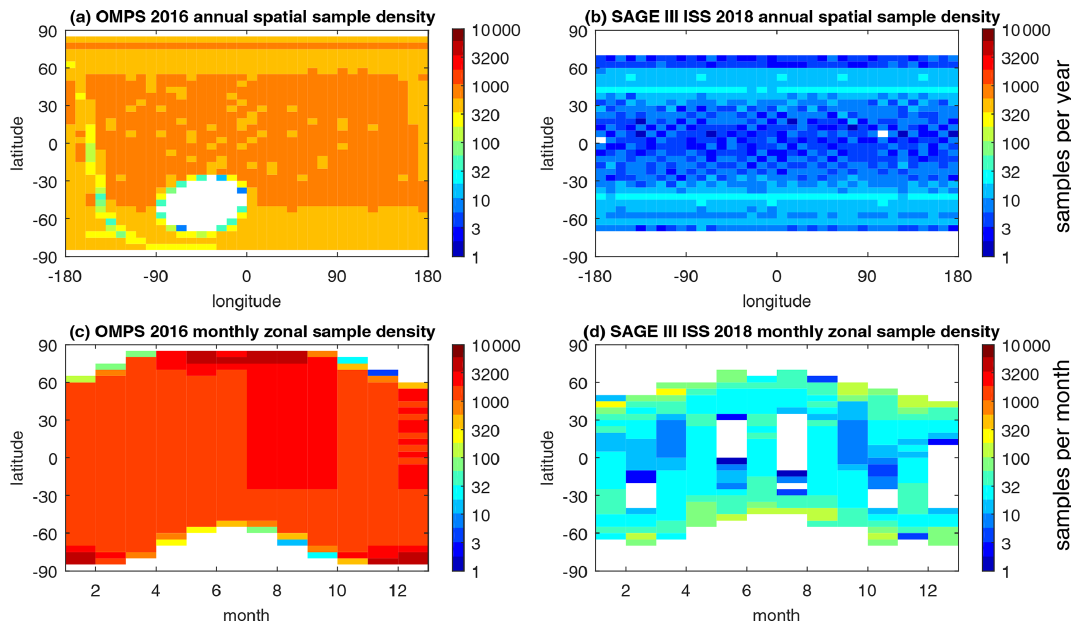
Figure 4. Annual (a, b) and monthly (c, d) sample density for OMPS-LP Suomi-NPP (a, c) and SAGE III/ISS (b, d) . The OMPS sampling gap over South America results from a filter that removes measurements affected by the South Atlantic Anomaly, which causes increased noise in measured radiances from transient particle strikes to the instrument